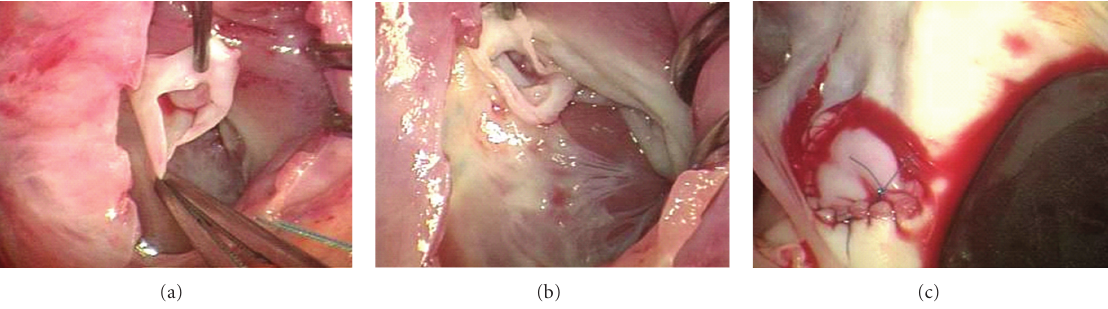
Figure 3: (a) Intraoperative image demonstrating ruptured right sinus aneurysm with visualization of the intact noncoronary cusps. (b) Intraoperative picture demonstrating the 1 cm hole at the junction of the right coronary cusp and at the junction of the right noncoronary commissures. (c) Intraoperative picture after closure of the rupture with bovine pericardium